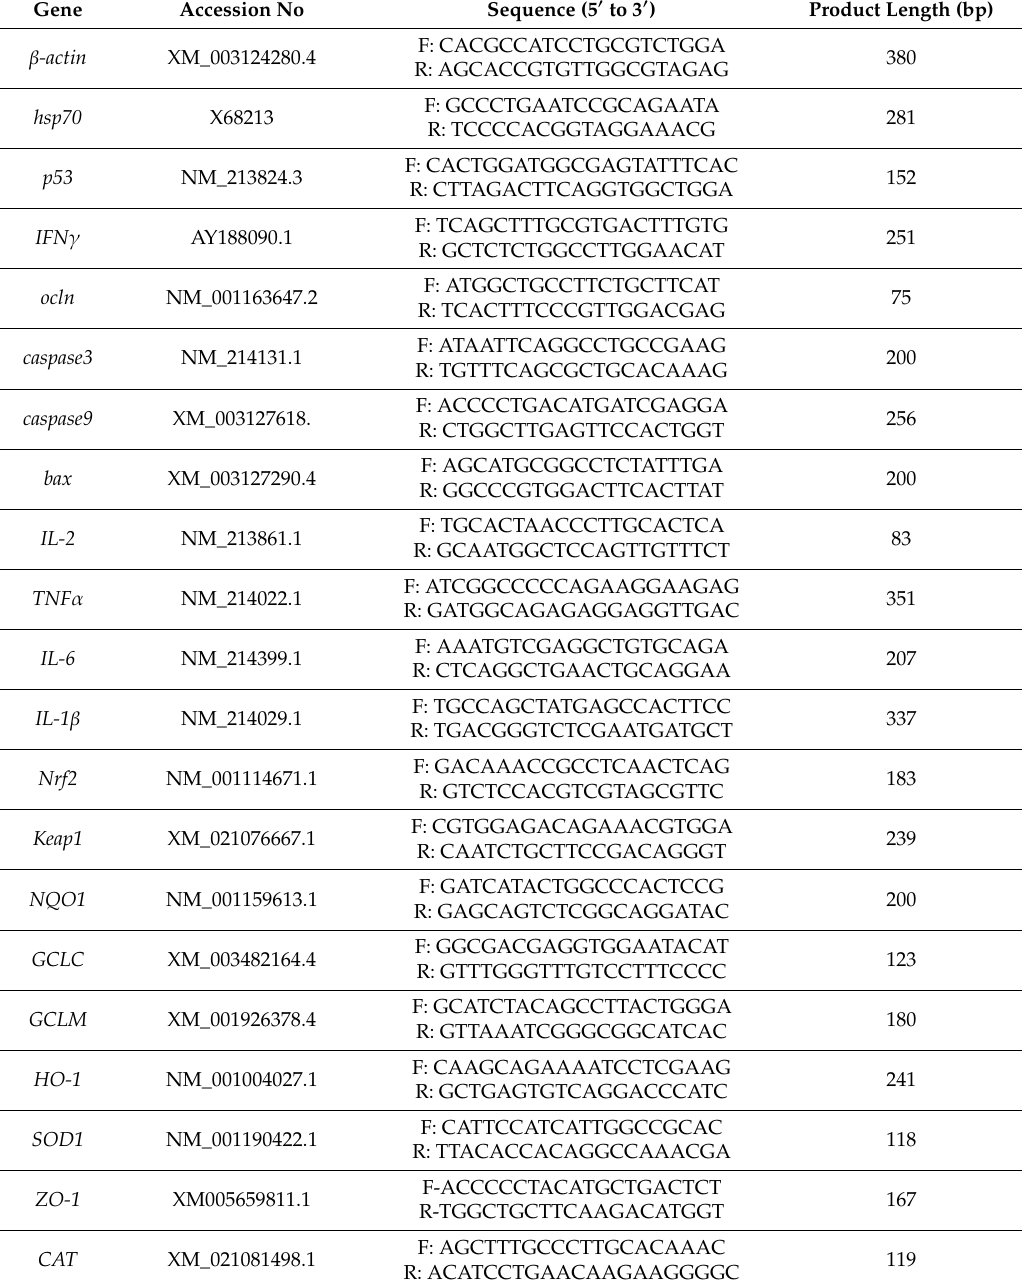
Table 1. Primer sequences used in quantitative real-time PCR